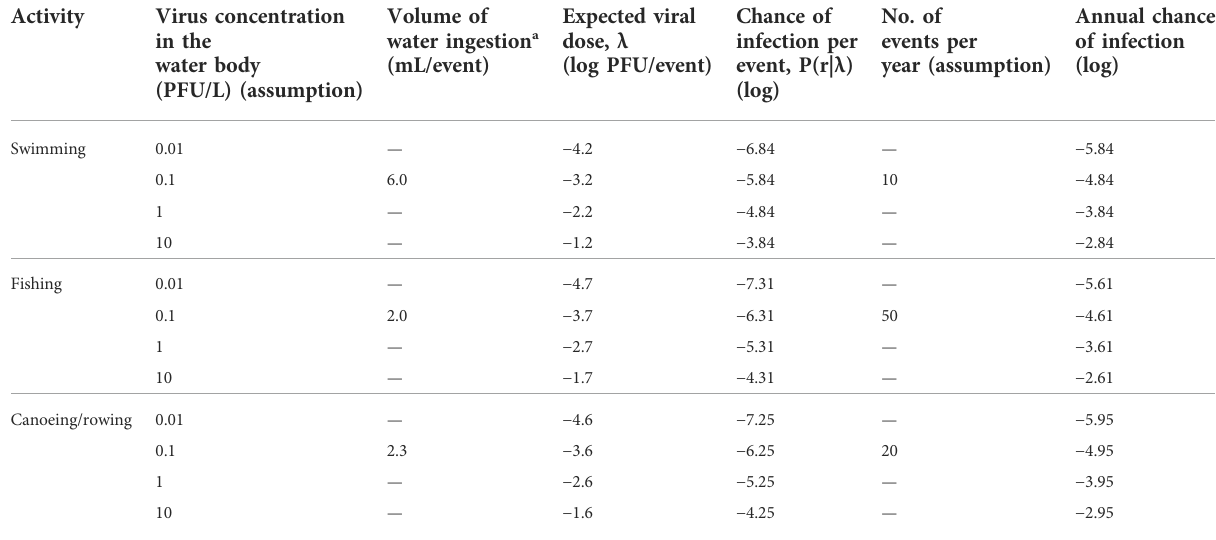
TABLE 5 Expected dose and probability of infection to SARS-CoV-2 for various water activities under various viral concentration scenarios, adopted from Kumar et al. (2021). Activity Virus concentration in the water body (PFU/L) (assumption)